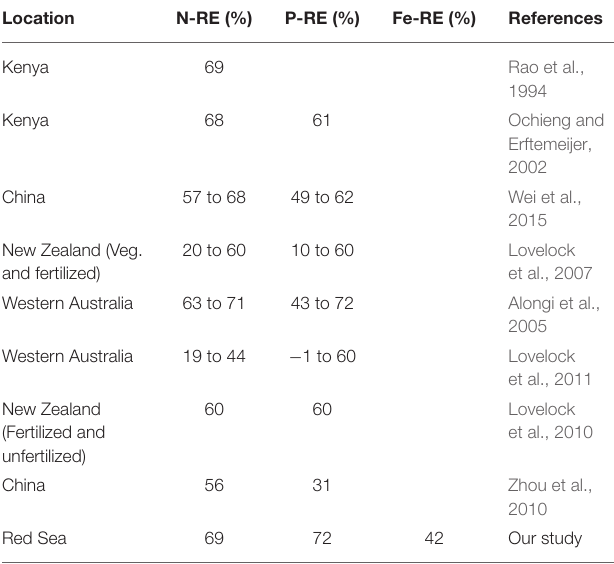
TABLE 4 | Comparison of nutrients resorption in Avicennia marina leaves from different locations worldwide.